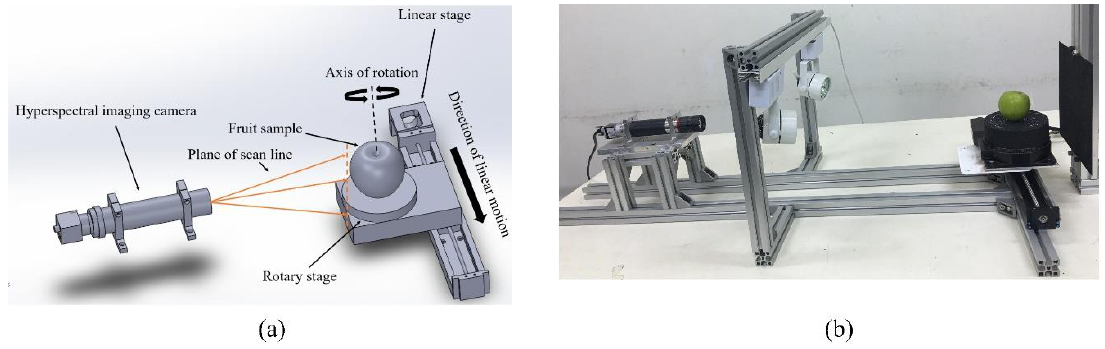
Figure 2. ( a ) Schematic of the hyperspectral imaging system and ( b ) the experimental setup.